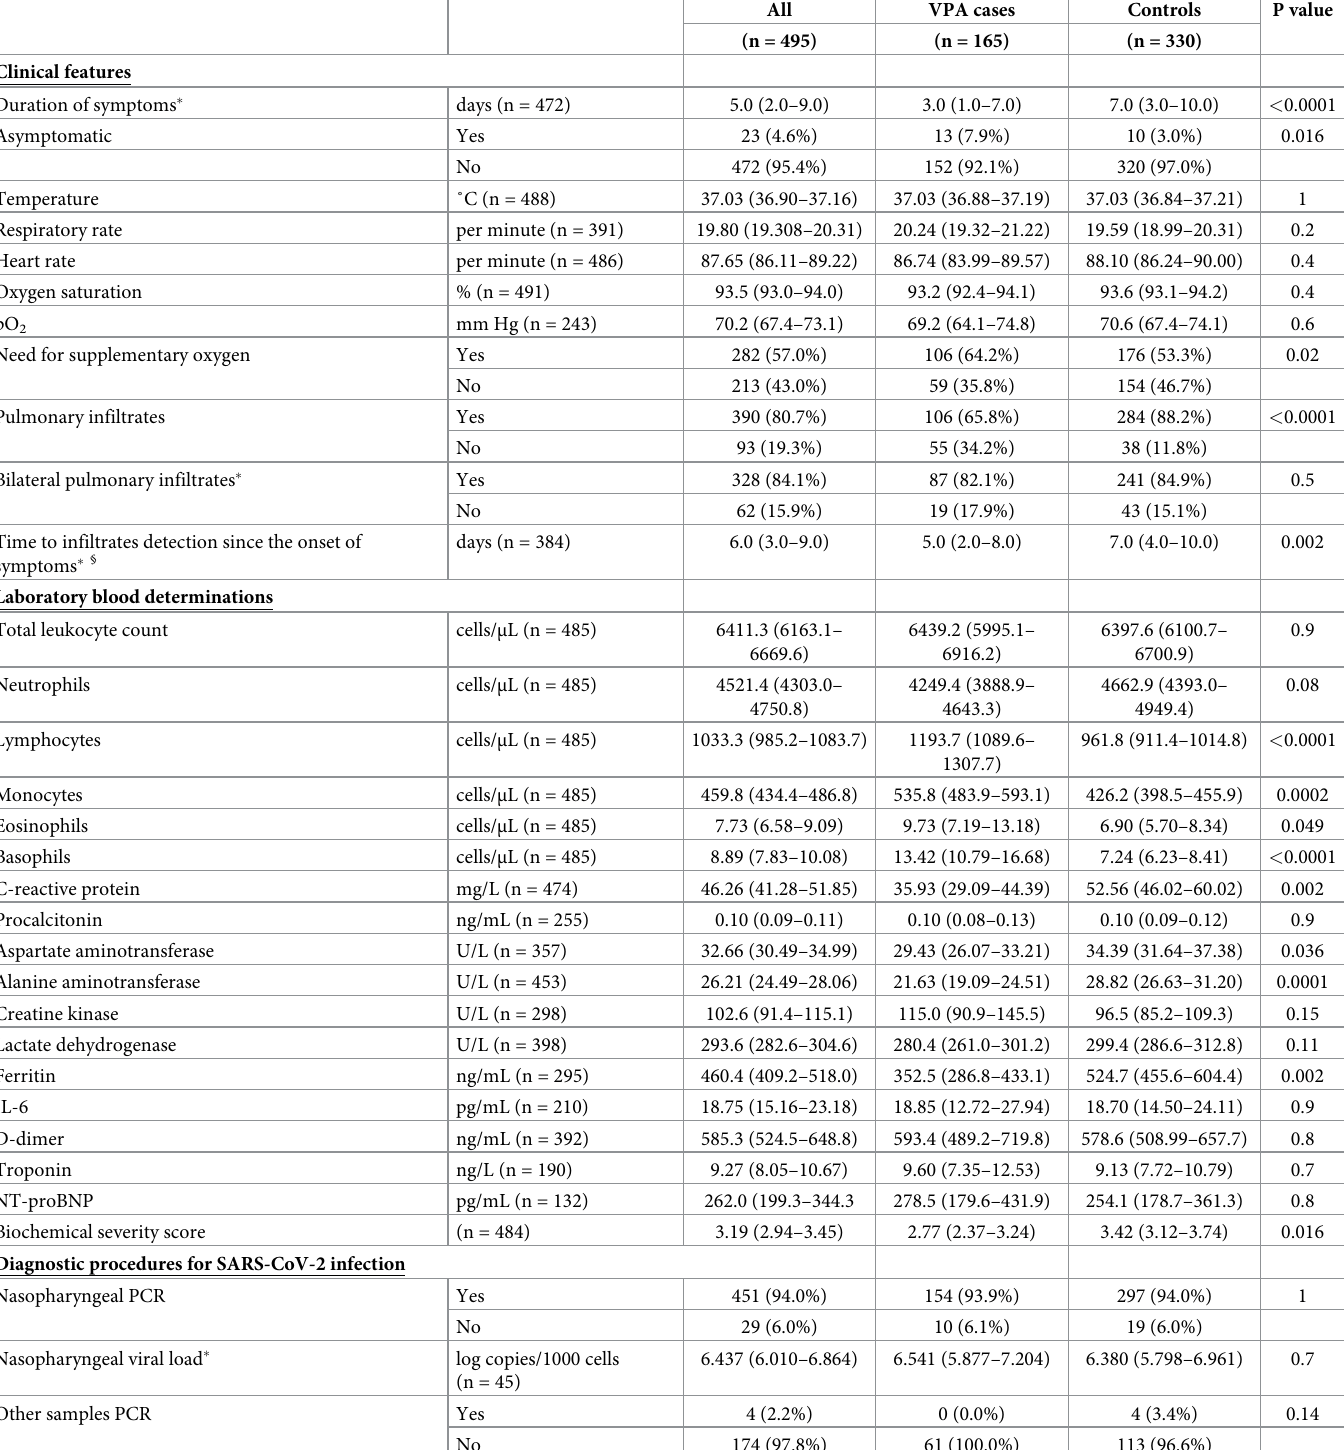
Table 2. Clinical, radiologic, laboratory and diagnostic procedures at